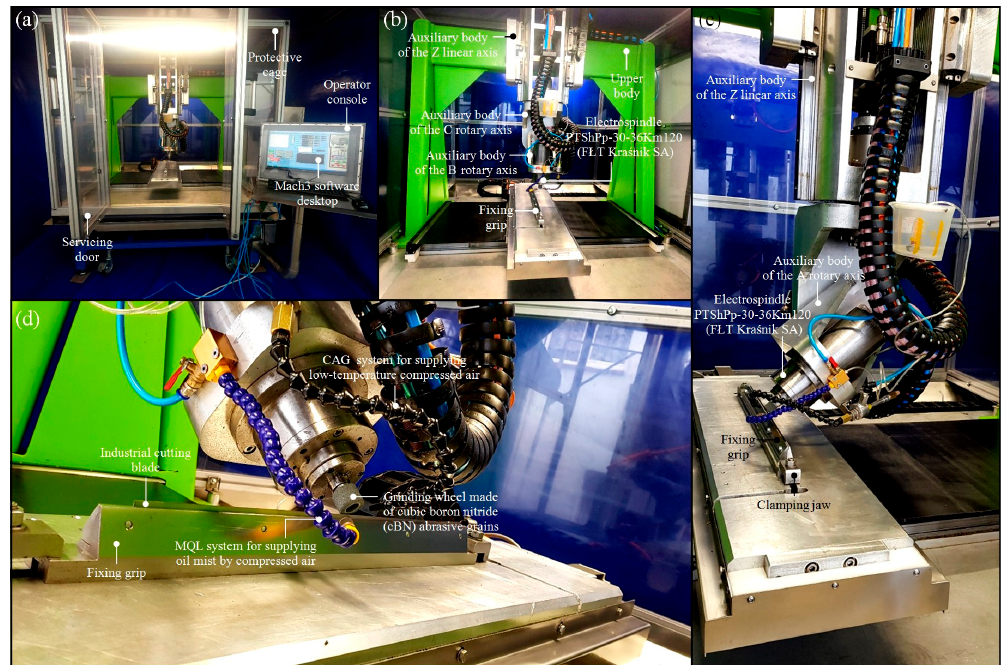
Figure 5. Construction phase of a 5-axis CNC grinding machine for the precision grinding process of the cutting edges of industrial cutting blades: ( a ) General view of a complete technological machine; ( b ) general view of the upper body and auxiliary bodies of the Z linear axis, as well as the C and B rotary axes inside the protective cage; ( c,d ) detailed view of the auxiliary bodies of the Z linear axis, as well as the C and B rotary axes, with electrospindle, cooling–lubricating system, and fixing grip with mounted industrial cutting blade.